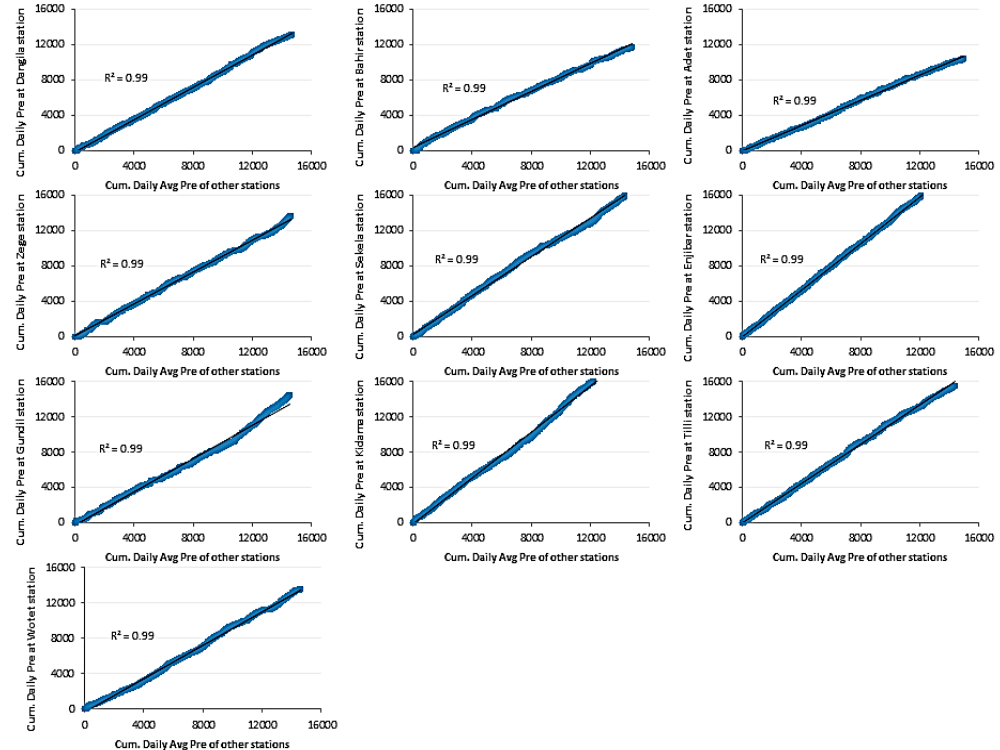
Figure 2. Cumulative daily rainfall time series for each in-situ station against cumulative daily average rainfall of remaining in-situ stations.